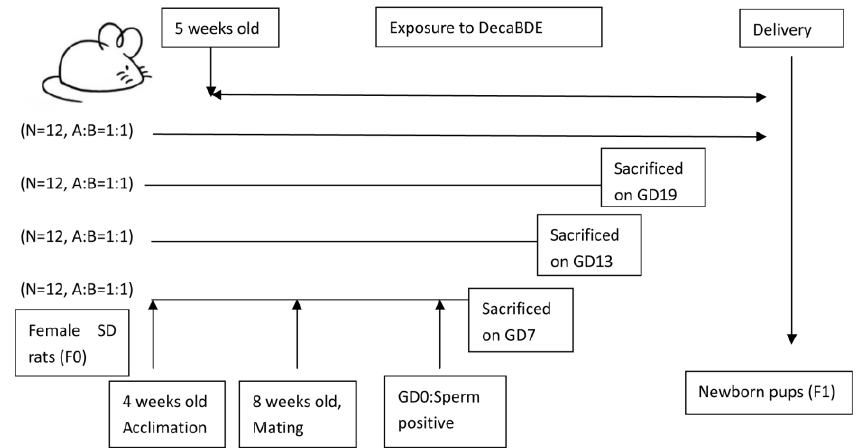
Figure 1. Experimental design of the animal study. Forty-eight Sprague-Dawley (SD) rats were given 1000 mg bromodiphenyl ether (DecaBDE)/kg birth weight (bw) per day from 5 weeks of age to delivery (mating with males at 8 weeks of age). A: control group, B: DecaBDE-treated group